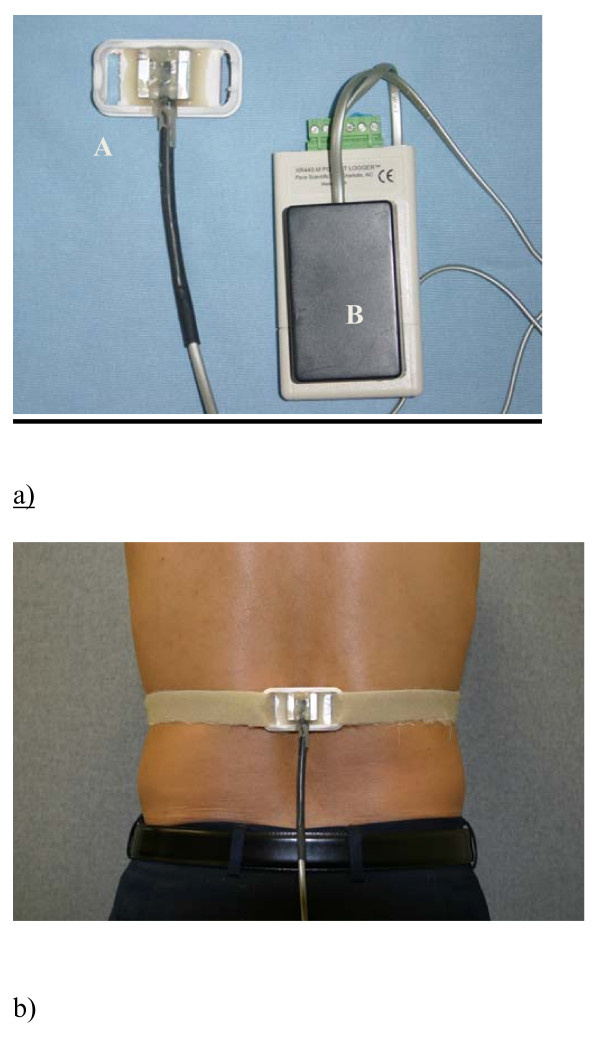
Ambulatory postural monitoring device. a) the accelerometer (A) and the data logger (B). b) Strapping for secure attachment of the accelerometer to the back.